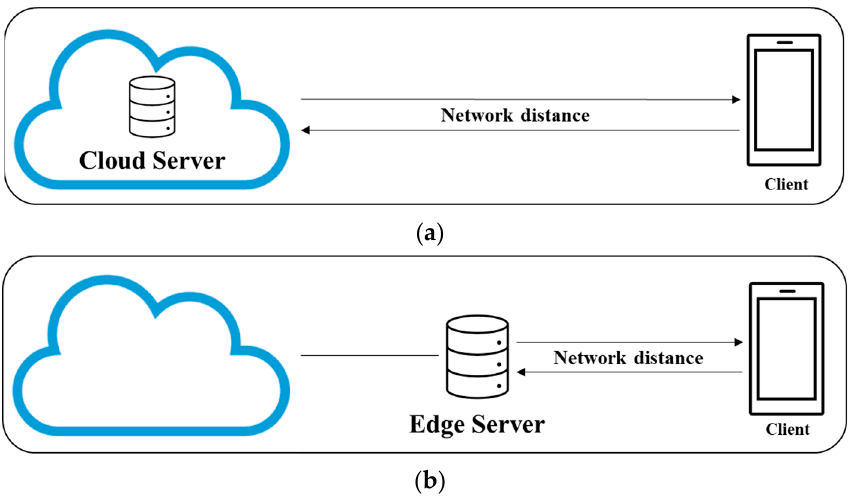
Figure 2. Network type and physical distance: ( a ) cloud server; ( b ) edge server.